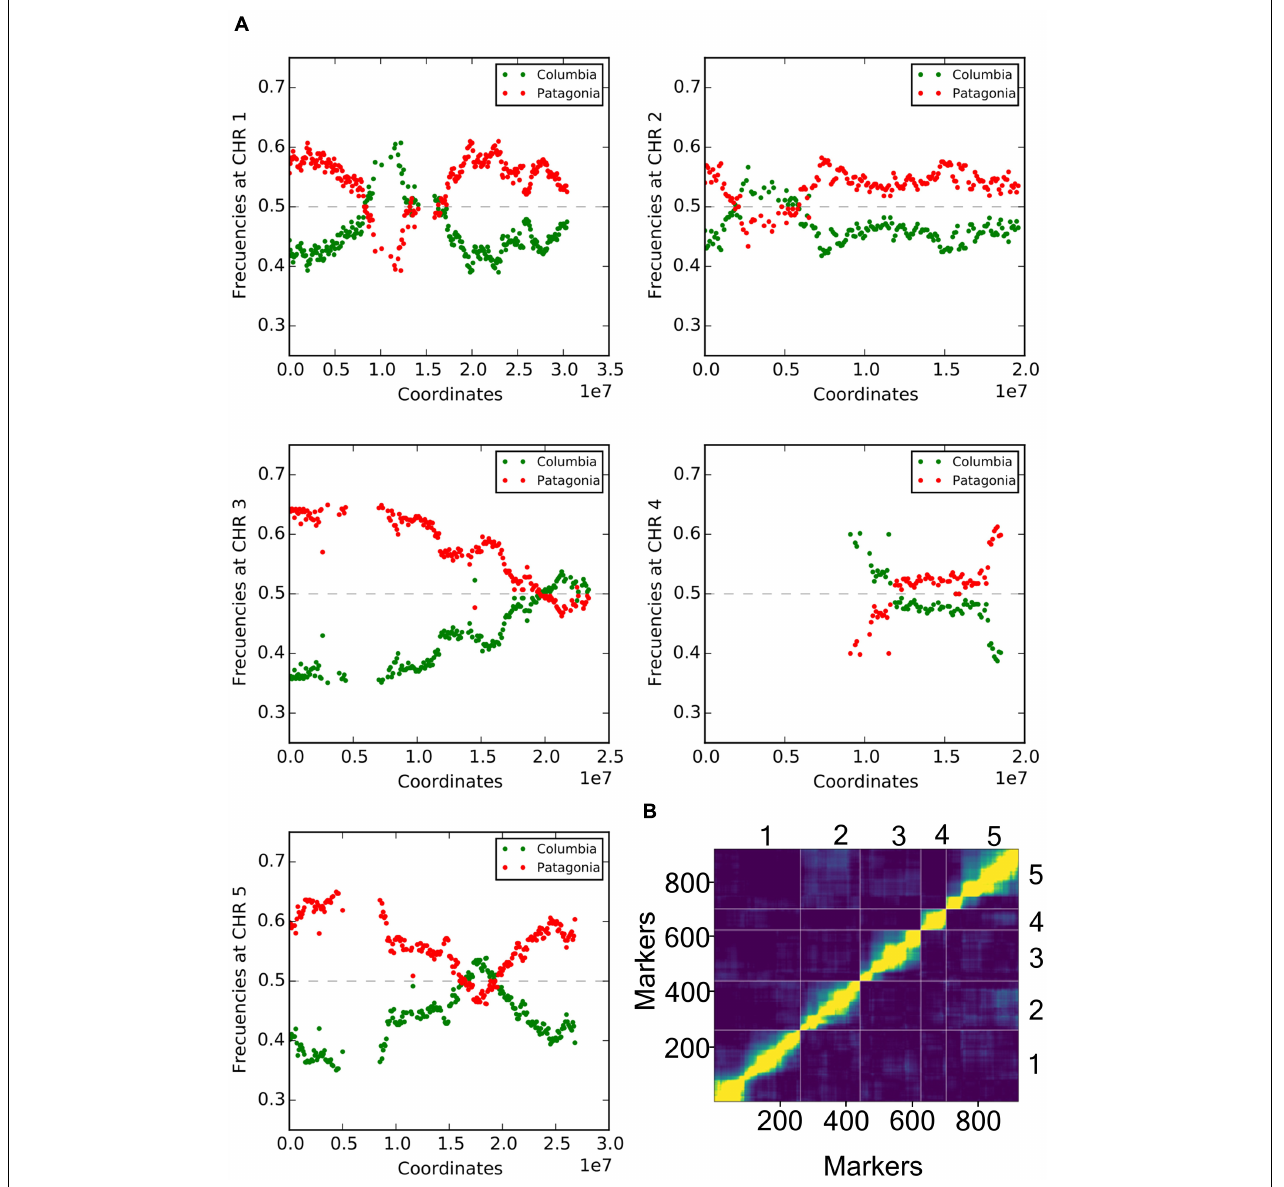
FIGURE 2 | Genetic characterization of Col-0 × Pat RIL population. (A) Frequency of allele occurrence for each genotyped marker across the population in each Arabidopsis chromosome. Figures show the distribution of markers as Col-0 or Pat segregation (green and red color, respectively), between 0 (no occurrence) and 1 (100% occurrence in the population). In all chromosomes, the markers ranked for Col-0 or Pat alleles between 35 and 65% occurrence, with the exception for the upper arm of chromosome IV (data not shown). (B) Pairwise recombination fractions and LOD scores for all pairs of markers are shown in the upper-left and in the lower-right triangles, respectively, for the five chromosomes. High correlation between markers indicates marker linkage shown in yellow color, while low correlation values indicating unlinked markers is shown in the blue color. The 920 available markers are numerically assigned and placed in physical genetic order, while each chromosome is limited by vertical and horizontal